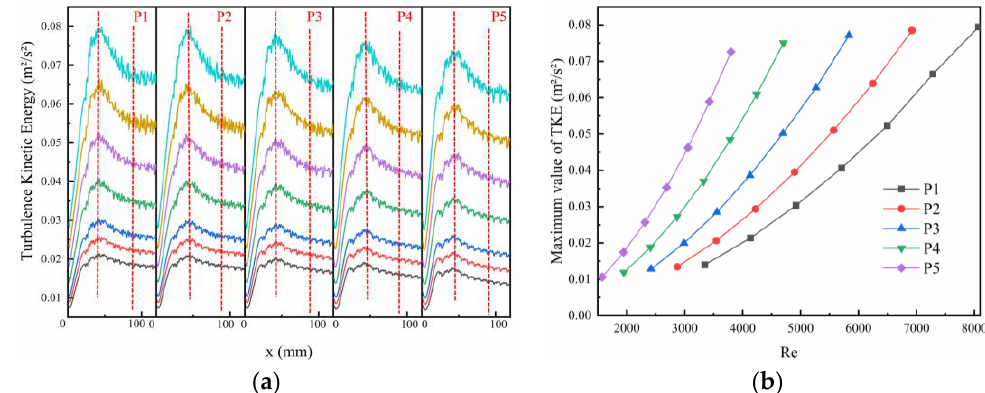
Figure 19. Distributions of turbulent kinetic energy ( a ) and its maximum value ( b ) for different Reynolds numbers and Prandtl numbers.